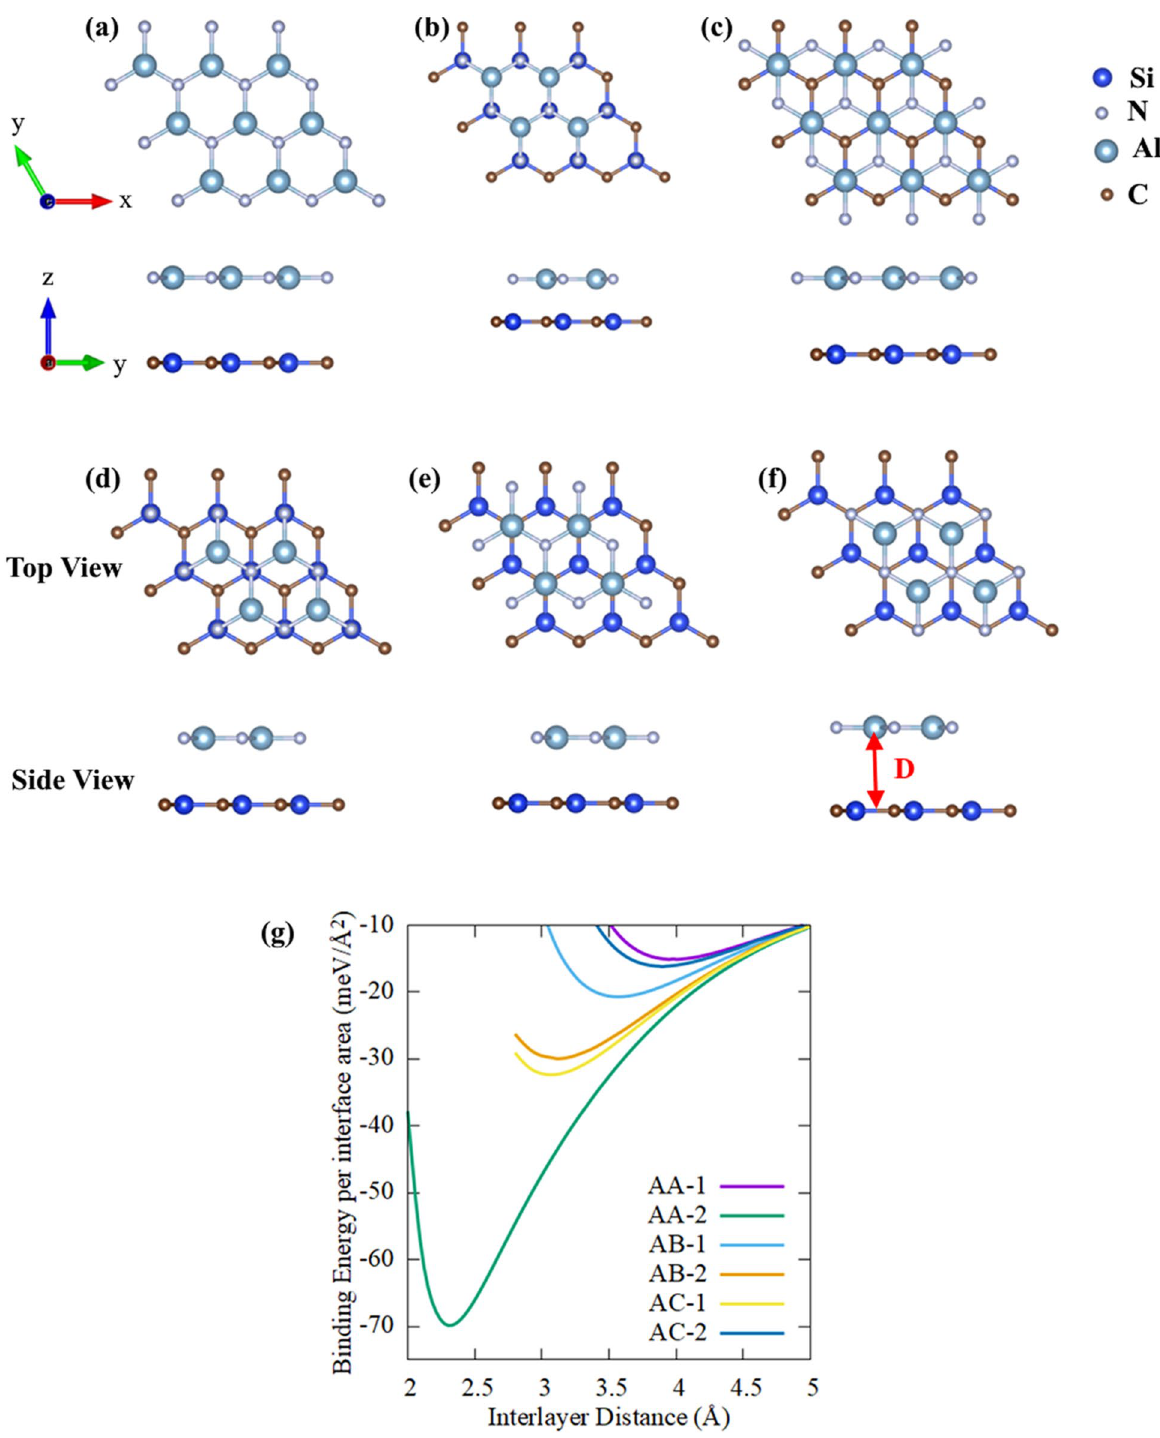
Figure 1. Top and side views of the SiC/AlN bilayer heterostructure in the six configurations considered: ( a ) AA-1, ( b ) AA-2, ( c ) AB-1, ( d ) AB-2, ( e ) AC-1, ( f ) AC-2. ‘D’ represents the equilibrium layer spacing between the SiC layer and the AlN layer. ( g ) Variation of the binding energy per interface area as a function of layer spacing between the SiC and AlN layers for the six stacking